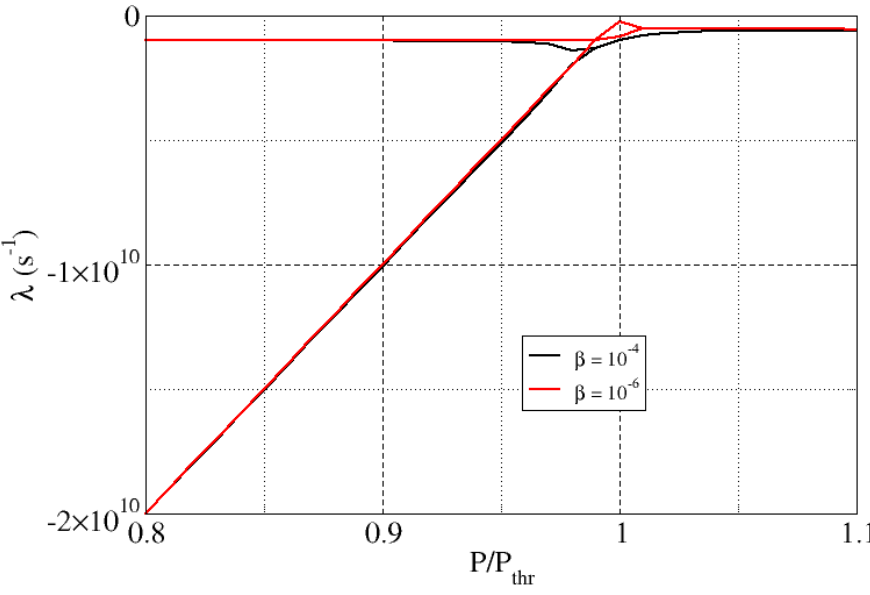
Figure 6. Real part of the eigenvalues derived from the stability analysis of the rate equations model, Equations (12) and (13) for a borderline microlaser ( β = 10 − 4 ) and for a macroscopic laser β = 10 − 6 )—cf. figure